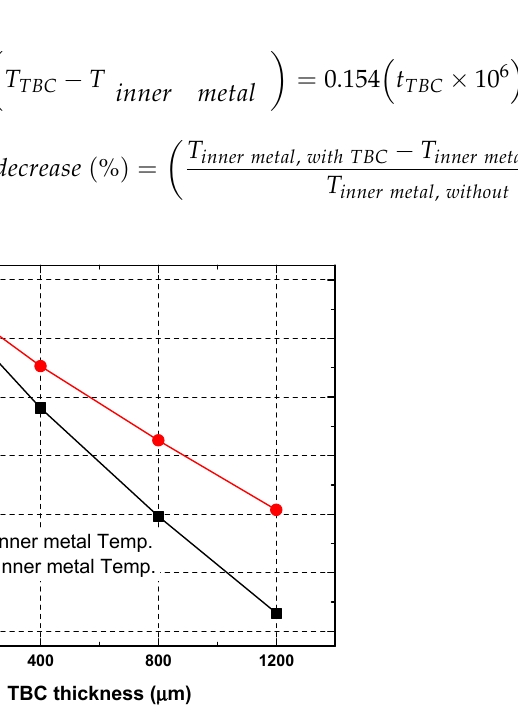
Figure 18. Percentage comparison of the inner metal temperature based on the TBC thickness. The thermal stress analysis based on the wall 𝑑𝑇 and thermal expansion coefficient were performed to show the stress contour based on the TBC thickness in Figure 19. The maximum stress was observed in the forward shell section due to the hot gas touching the combustor liner and C-channel due to the lowest wall HTC by the impingement jet. Over- all, the stress level was decreased near the nozzle, in the collision jet, and in the uneven cooling area as TBC thickness increased. This thermal stress analysis revealed that the TBC was effective in reducing the CL metal stress in high temperature regions. As discussed earlier, the method to predict the creep lifetime of the CL by using the calculated wall temperature and von Mises equivalent stress, along with Larson–Miller rupture curves and the creep lifetime of the inner metal and outer metal surface of the CL